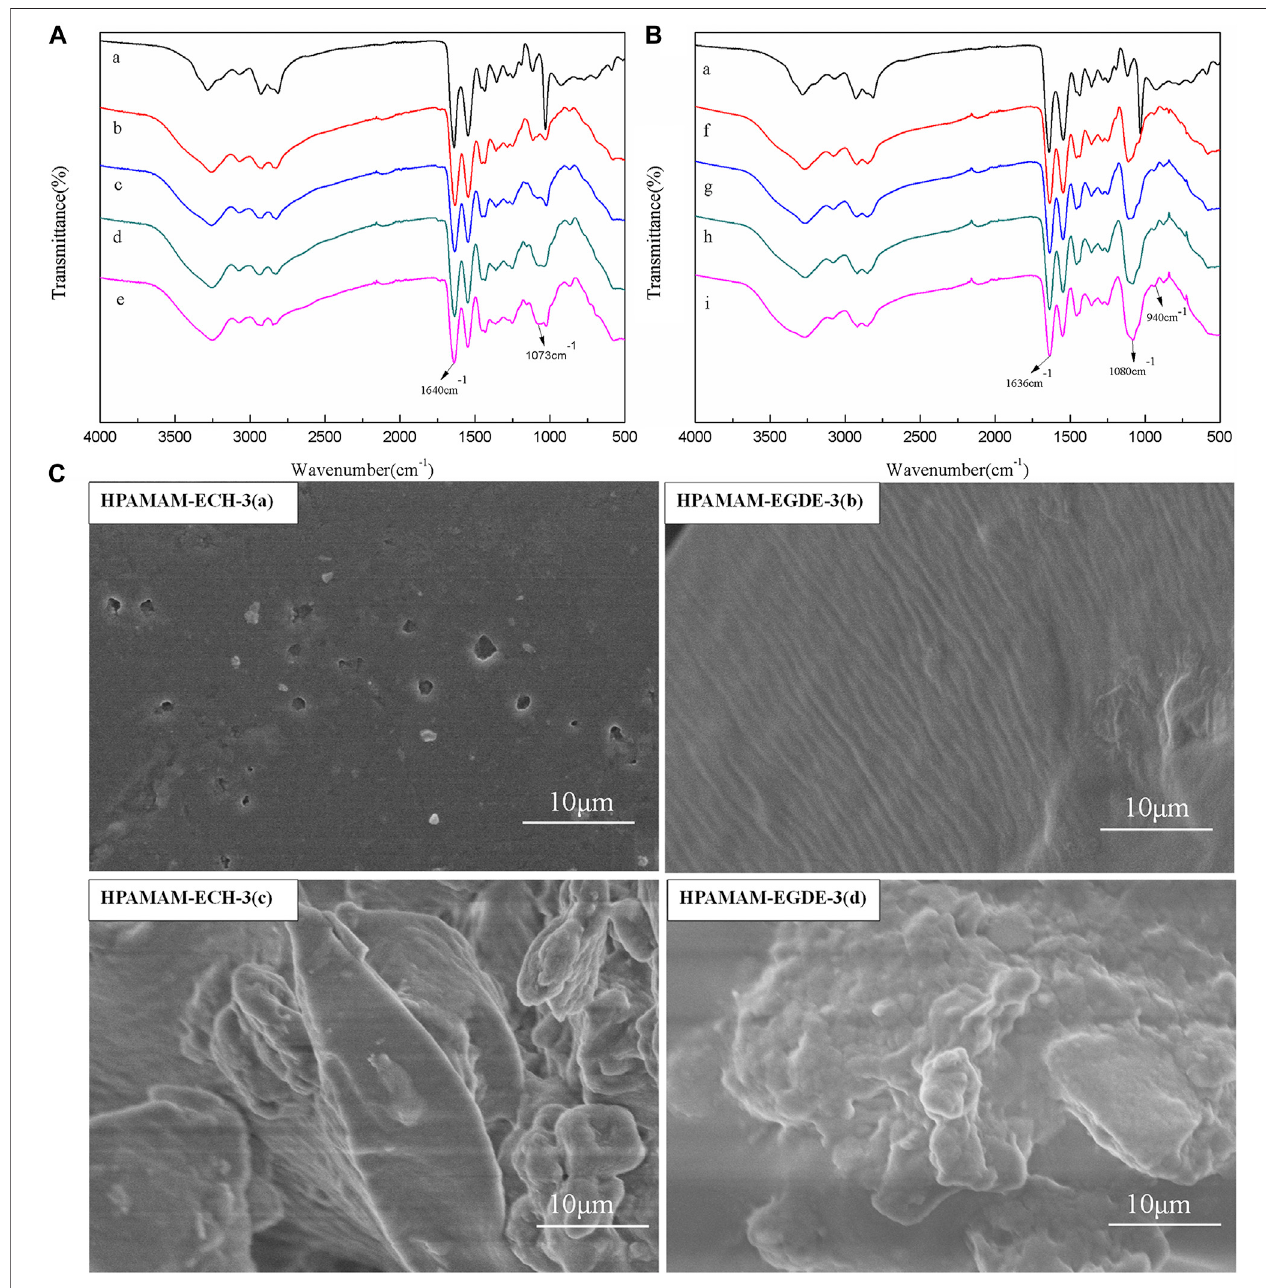
FIGURE 1 | (A) IR spectra of HPAMAM and HPAMAM-ECH samples: (a) HPAMAM, (b) HPAMAM-ECH-2, (c) HPAMAM-ECH-3, (d) HPAMAM-ECH-4, (e) HPAMAM-ECH-5; (B) IR spectra of HPAMAM and HPAMAM-EGDE samples: (a) HPAMAM, (f) HPAMAM-EGDE-2, (g) HPAMAM-EGDE-3, (h) HPAMAM-EGDE-4, (i) HPAMAM-EGDE-5; (C) FE-SEM images of HPAMAM-ECH-3 and HPAMAM-EGDE-3: (a, b) surface morphology, (c, d) internal form.